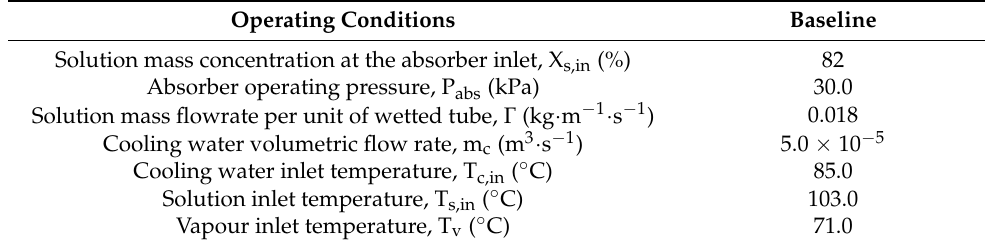
Table 2. Operating conditions used in modelling the horizontal tube falling-film